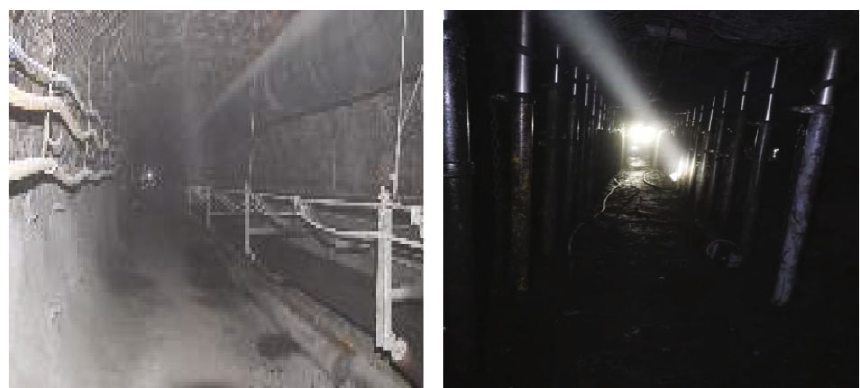
Figure 14: The result of roadway support